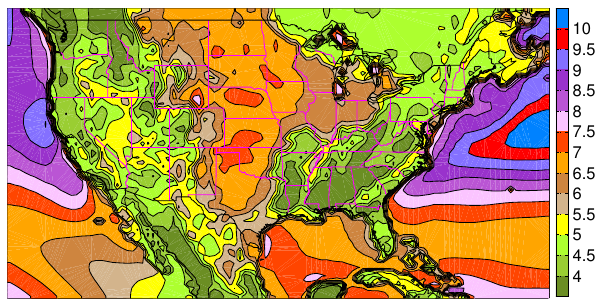
Fig. 9a. Geographical variation of the mean wind at 80m in the US The white-shaded regions have annual mean wind speeds that are less than or equal to 4ms − 1